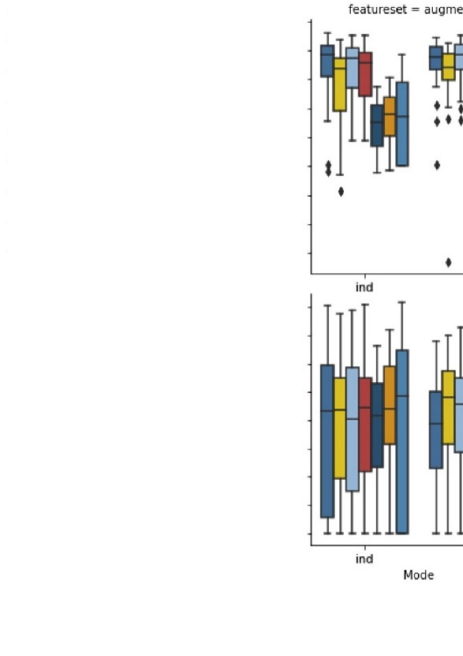
( b ) Figure 4. ( a ) F1 score equal to 0 for mode ‘individual’ and corresponding scores of mode ‘all’; ( b ) F1 score equal to 0 for mode ‘all’ and corresponding scores of mode ‘individual’. The left graph in Figure 4 displays few cases where using mode ‘all’ leads to F1 scores from around 0.1 up to 0.4 higher than the ones for mode ‘individual’. Comparing the two graphs shows that there are more model predictions where the mode ‘all’ achieves F1 scores higher than 0 than the other way round. To determine when F1 score is low, Figure 5 shows the datapoints of occupancy in the test data against the datapoints of occupancy in the training data, colored by their corresponding F1 score for mode ‘individual’.